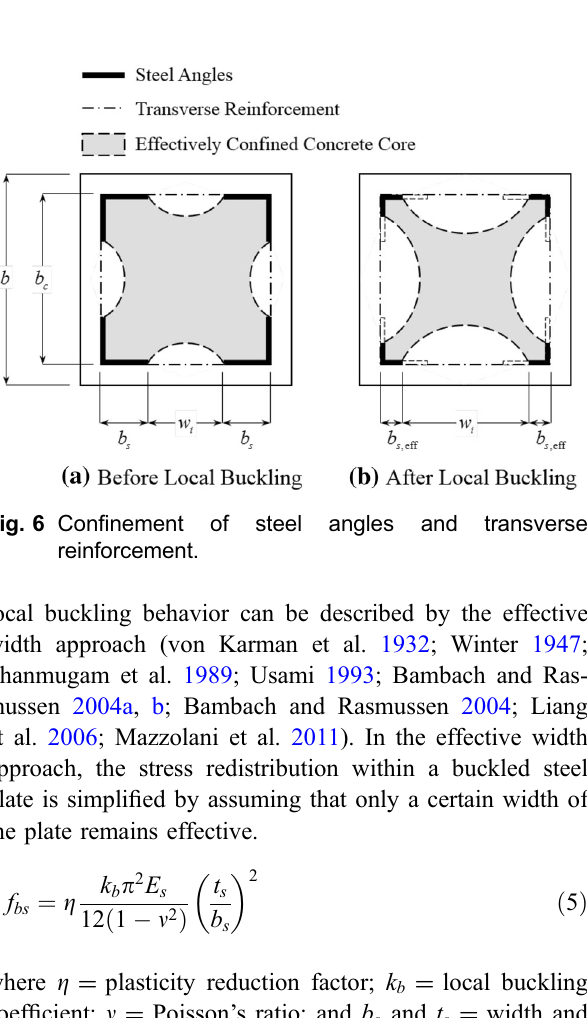
Fig. 5 Spalling of corner concrete cover.